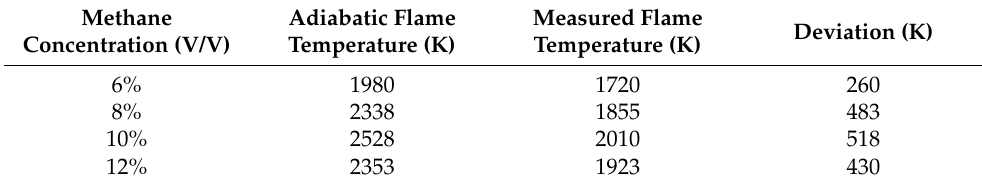
Table 1. Flame temperature at various methane concentrations in absence of